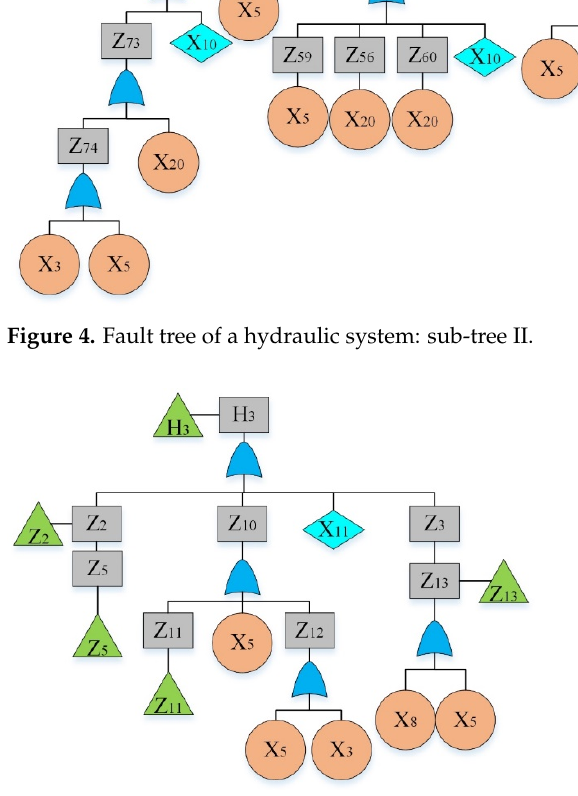
Figure 5. Fault tree of a hydraulic system: sub-tree III.